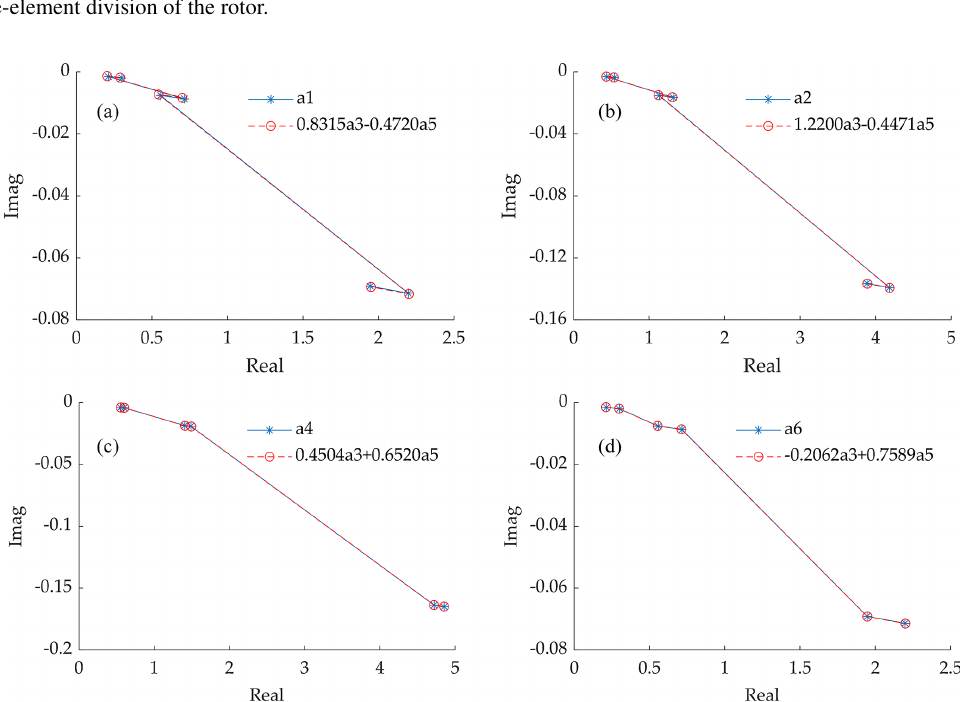
Figure 3. The relationship between EPs and redundant planes. (a) Disk 1. (b) Disk 2. (c) Disk 4. (d) Disk